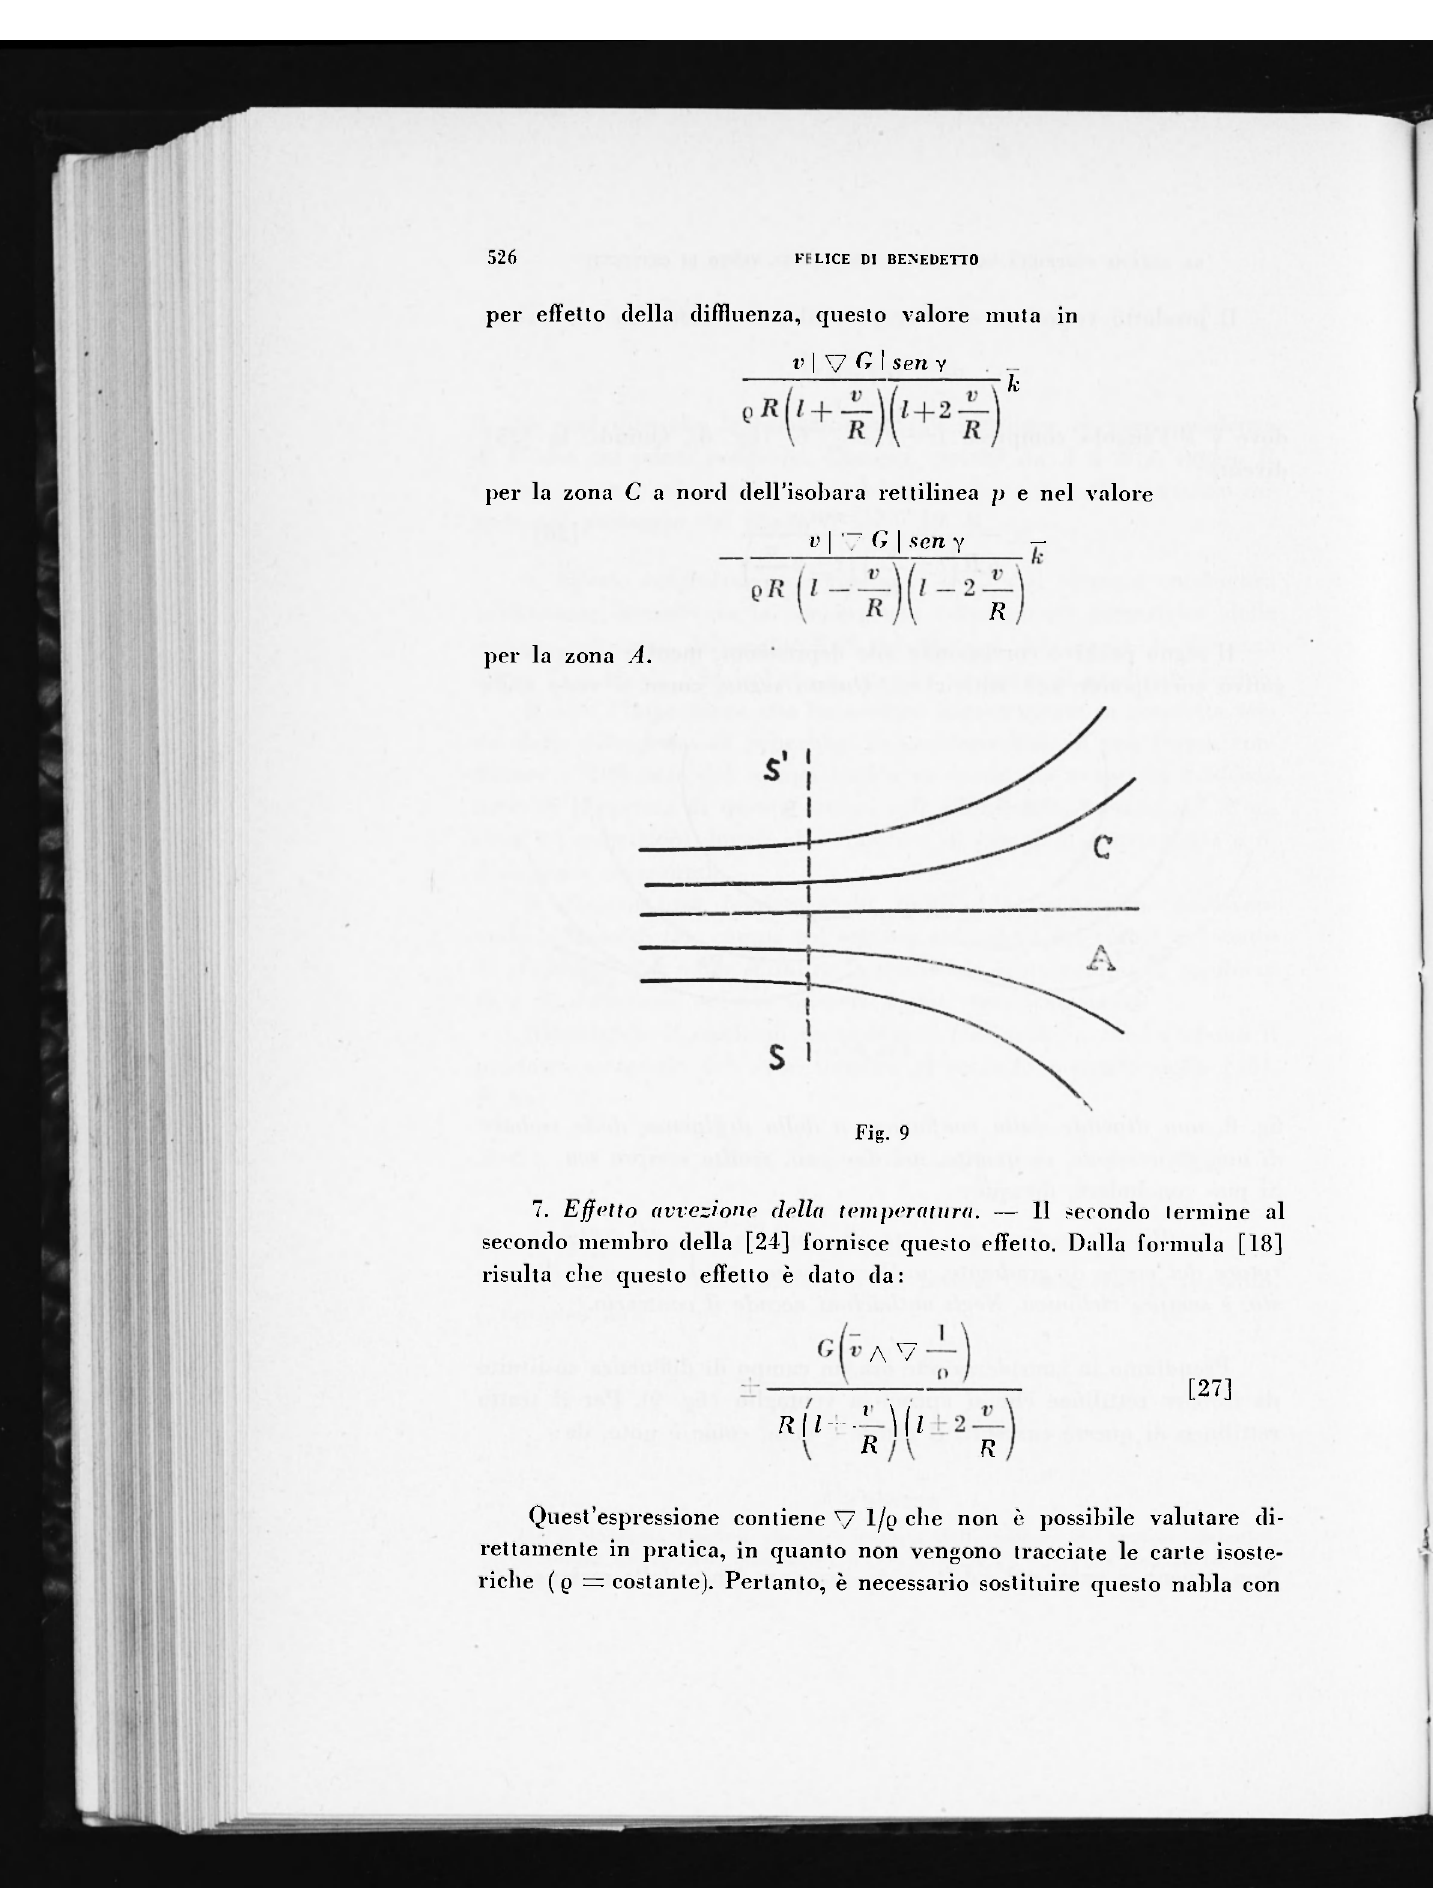
avvezione della temperatura. — 11 secondo termine